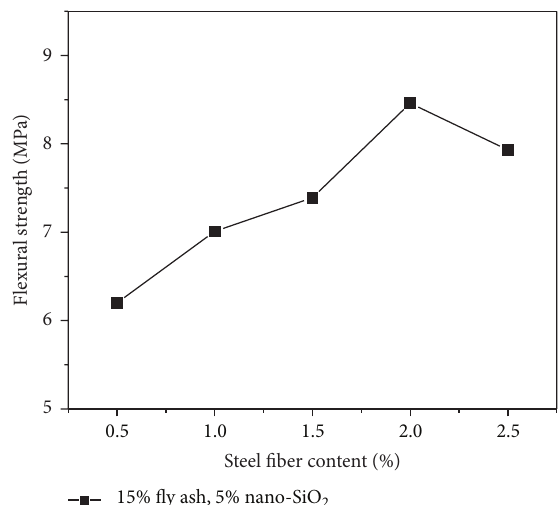
Figure 9: Effect of steel fiber content on flexural strength.